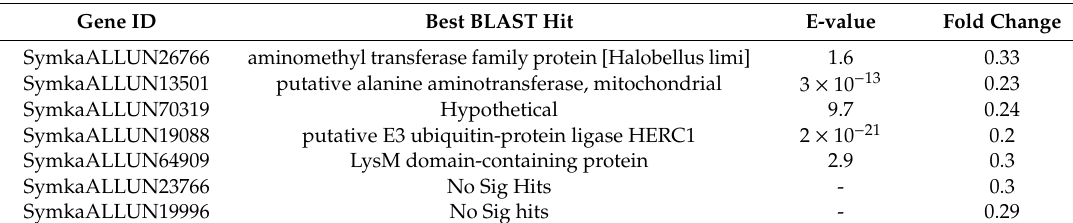
Figure 3. Comparison of transcript levels at LD 0 and LD 12. ( A ) A plot of read counts (as TPM, or transcripts per million) as the average of three samples at LD 12 are compared with the average of samples at LD 0. ( B ) An MA plot (fold-di ff erence as a function of mean read count) is shown for triplicate samples at each of the two times as determined by DESeq2. The 7 sequences determined to be significantly di ff erent ( p -adjust < 0.05; FDR = 0.1) are shown in red in both plots and are higher at LD 0 than at LD 12. Table 1. Best BLAST hit for the seven potentially light regulated genes identified (False Discovery Rate FDR =